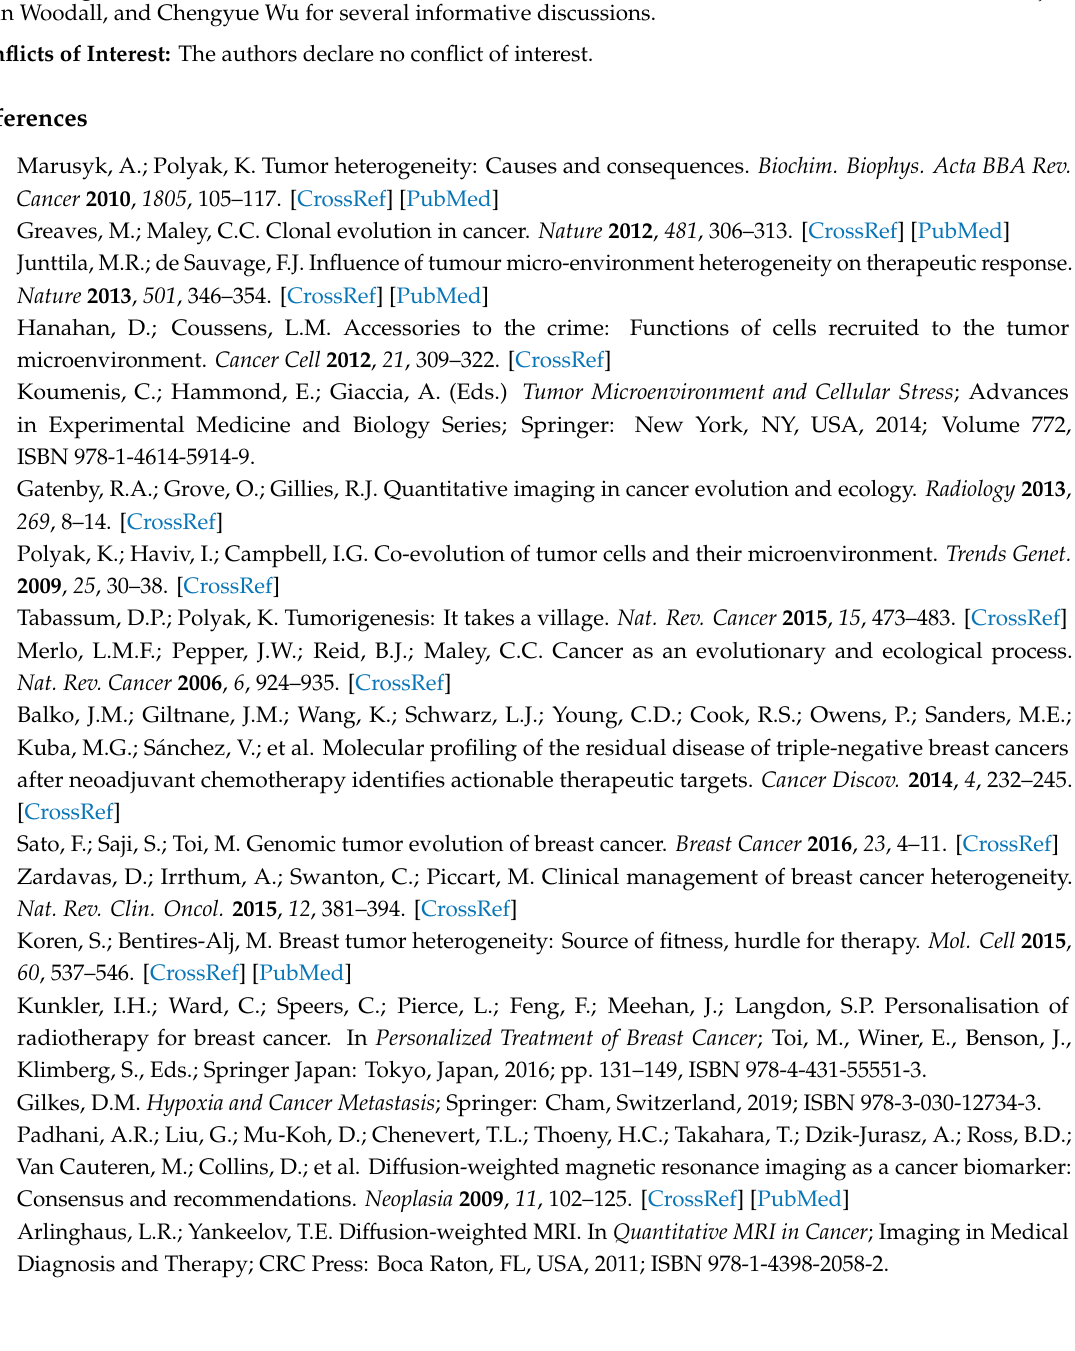
Figure S6: Example ROI segmentation, Figure S7: Image processing steps for histology data, Figure S8: Example central tumor ROI